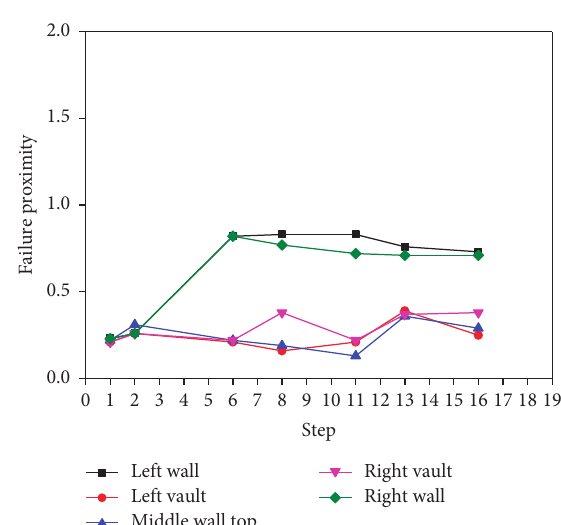
Figure 17: Failure proximity of scheme damage proximity of the surrounding rock reaches 0.93. During the construction of the lower steps of the right tunnel, the damage proximity of the surrounding rock reaches 1.2, and the surrounding rock is in a damaged state. Left vault: the surrounding rock here is relatively safe, and the maximum damage proximity is only 0.38. Middle wall top: the surrounding rock here is relatively safe, and the maximum damage proximity is only 0.36. Right vault: the surrounding rock here is relatively safe, and the maximum damage proximity is only 0.22. Right wall: the construction of the lower step of the right tunnel is the most unfavorable condition of the surrounding rock, and the damage proximity of the surrounding rock reaches 0.73, while the construction